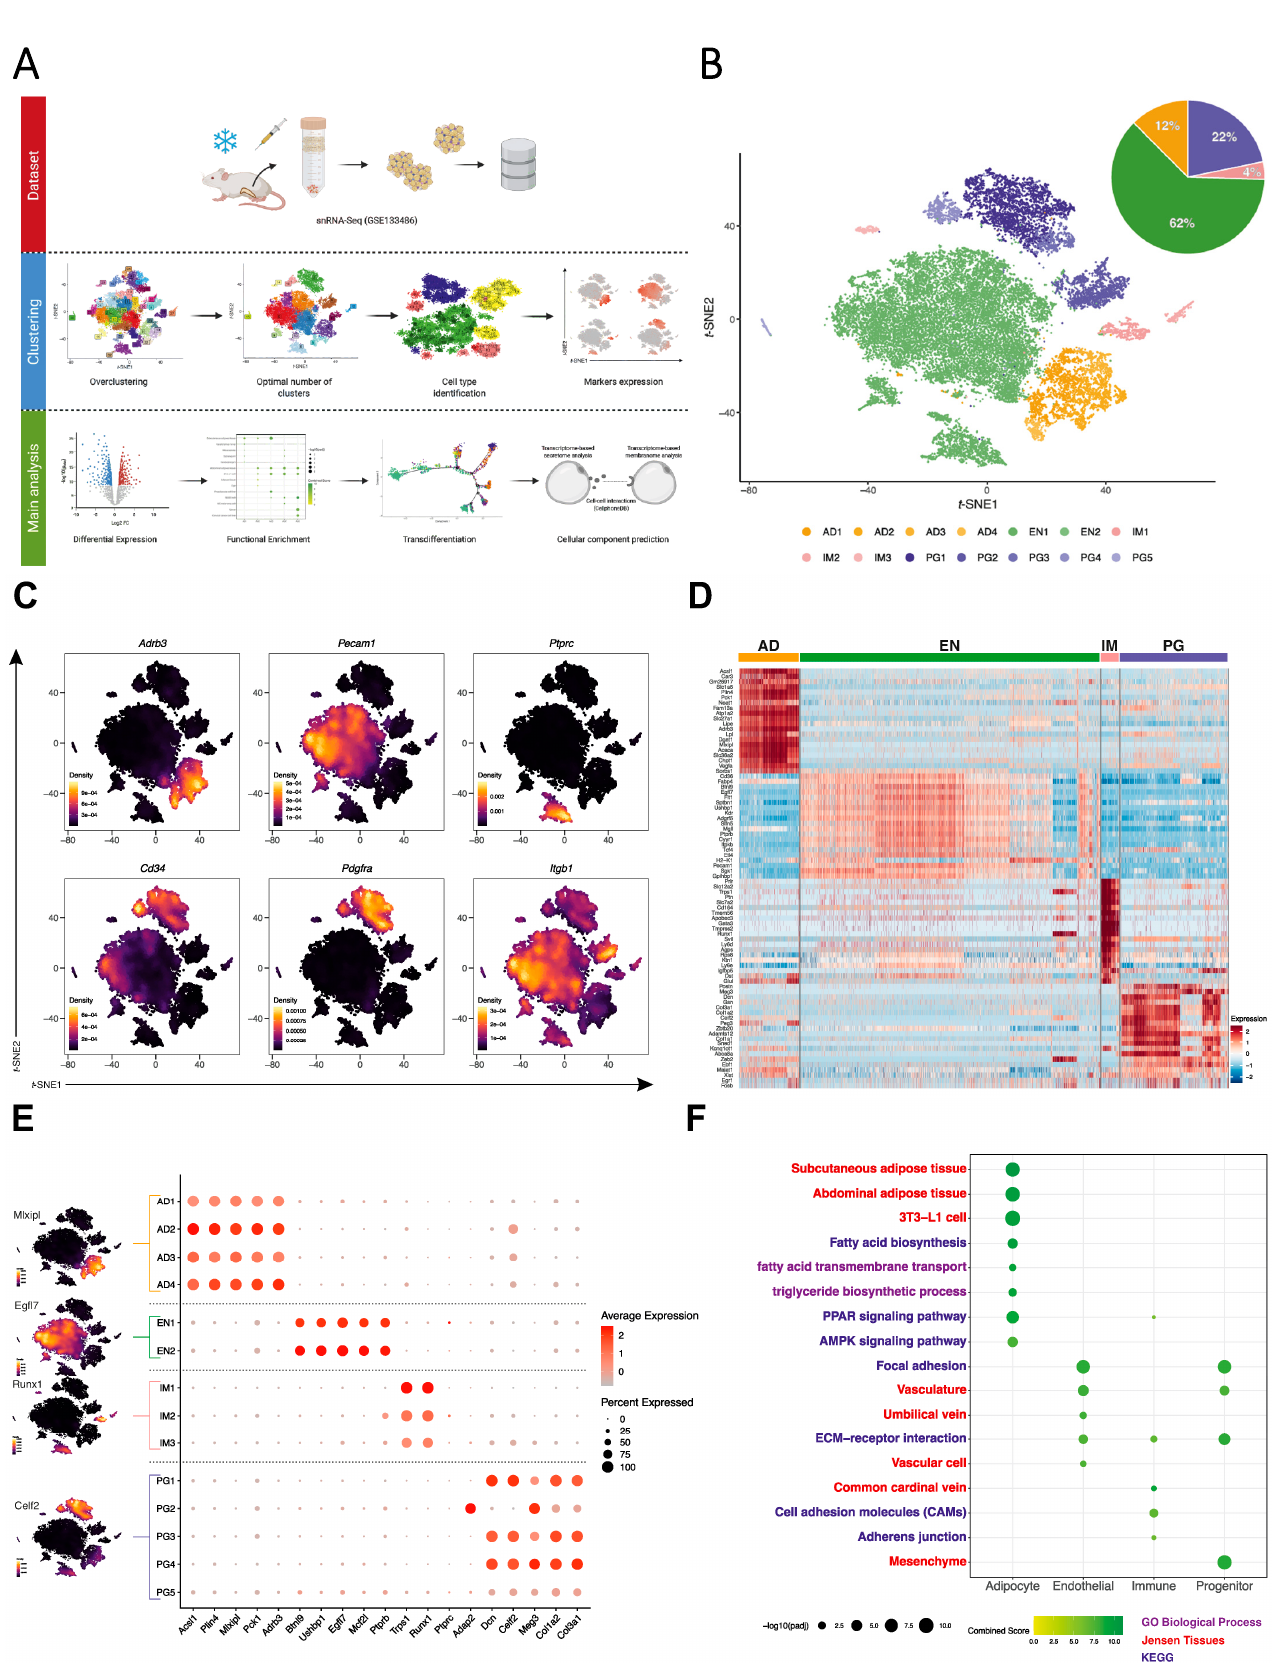
compared to all others. Genes are represented in rows and cell clusters in columns. ( E ) Gene-expression dot plot of select top five DEGs for each defined cell type. Rows depict clusters, while columns depict genes. The intensity of any given point indicates average expression, while its size represents the proportion of cells expressing a particular gene. ( F ) Selected top categories from ORA analysis of DEGs from the four cell types identified. The intensity of the color in the dotplot indicates the enrichment significance by the combined score. Circle sizes correspond to the -log10 adjusted p -value (padj). Gene set names are colored according to the GO biological process (purple), Jensen tissues (red), and Kyoto Encyclopedia of Genes and Genomes (KEGG, blue).